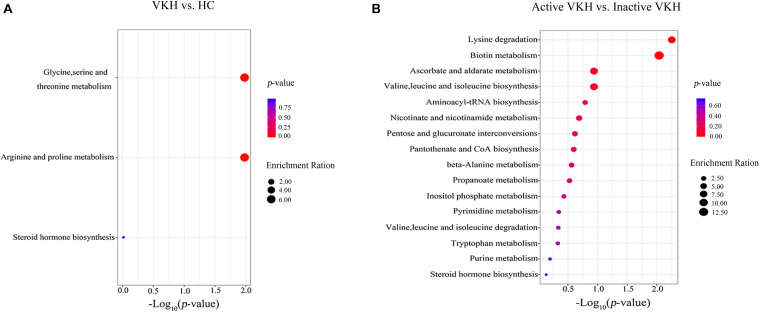
Pathway enrichment analysis of differential metabolites. Pathway enrichment analysis of differential metabolites identified in VKH versus healthy controls (A) and in active VKH with inactive VKH (B). The x-axis represented the p value and the y-axis represented the pathways. The color of dots indicates pathway enrichment significance. The size of dots indicates pathway impact. VKH, Vogt-Koyanagi-Harada disease; HC, healthy controls.